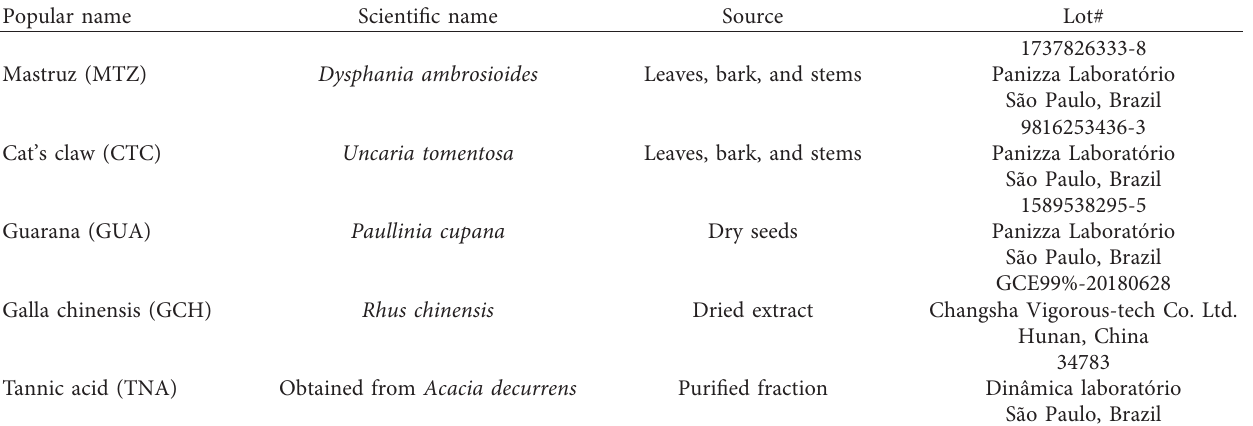
Table 1: Vegetable drugs selected for the present